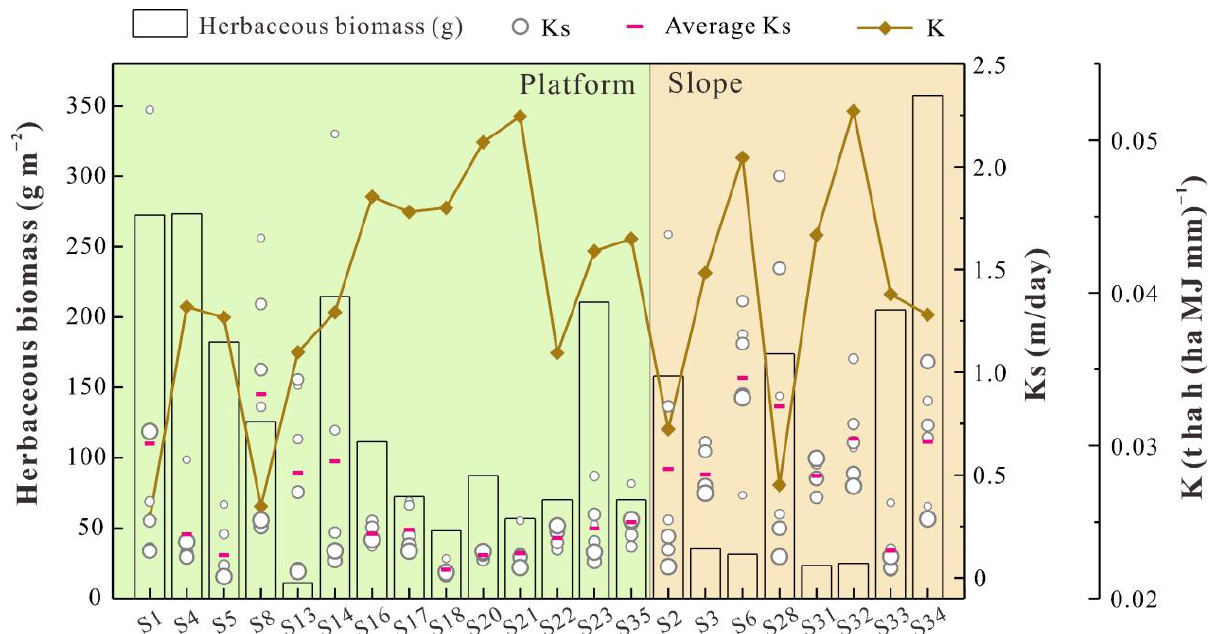
Figure 2. The distribution of K factor, Ks and herbaceous biomass at different sample sites. The K factor refers to the average value at 0–10 cm and 10–20 cm. The vertical distribution characteristics of Ks are presented by the bubble chart, where the larger bubbles represent deeper soil samples.